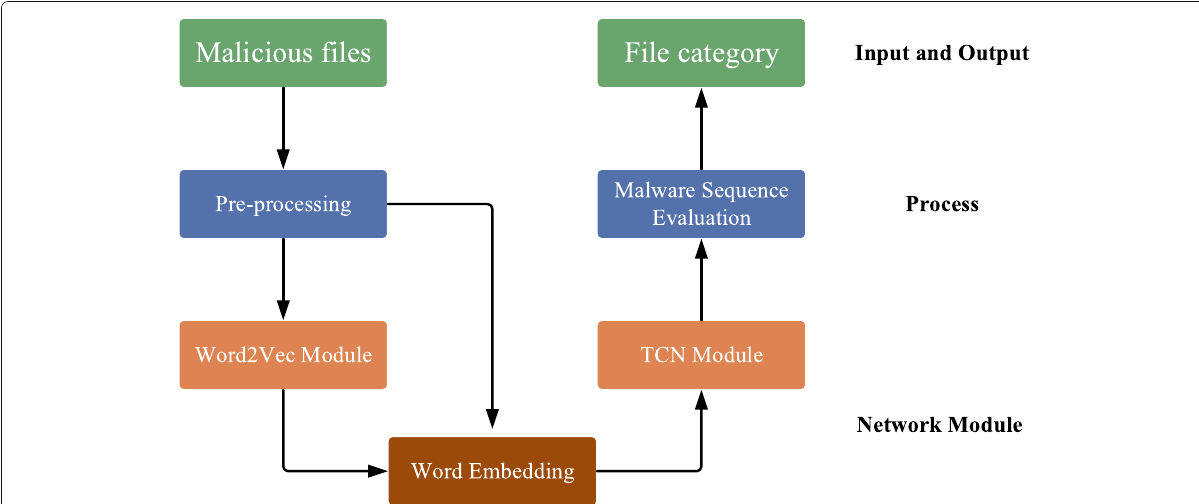
Fig. 3 The whole process of our proposed scheme. The whole process consists of input, output, preprocessing and test set validation process, and three network modules Word2Vec pre-trained model, input embedding module and TCN categorization module inadequate information for family classification and lead better than Word2Vec-based LSTM. More details about in much noise for feature representation, are eliminated the proposed scheme are described in the following parts. in our scheme. Considering the categorization network, TCN in our scheme has longer effective memory due to the dilated convolution structure. Moreover, residual structure is another reason that our scheme performs